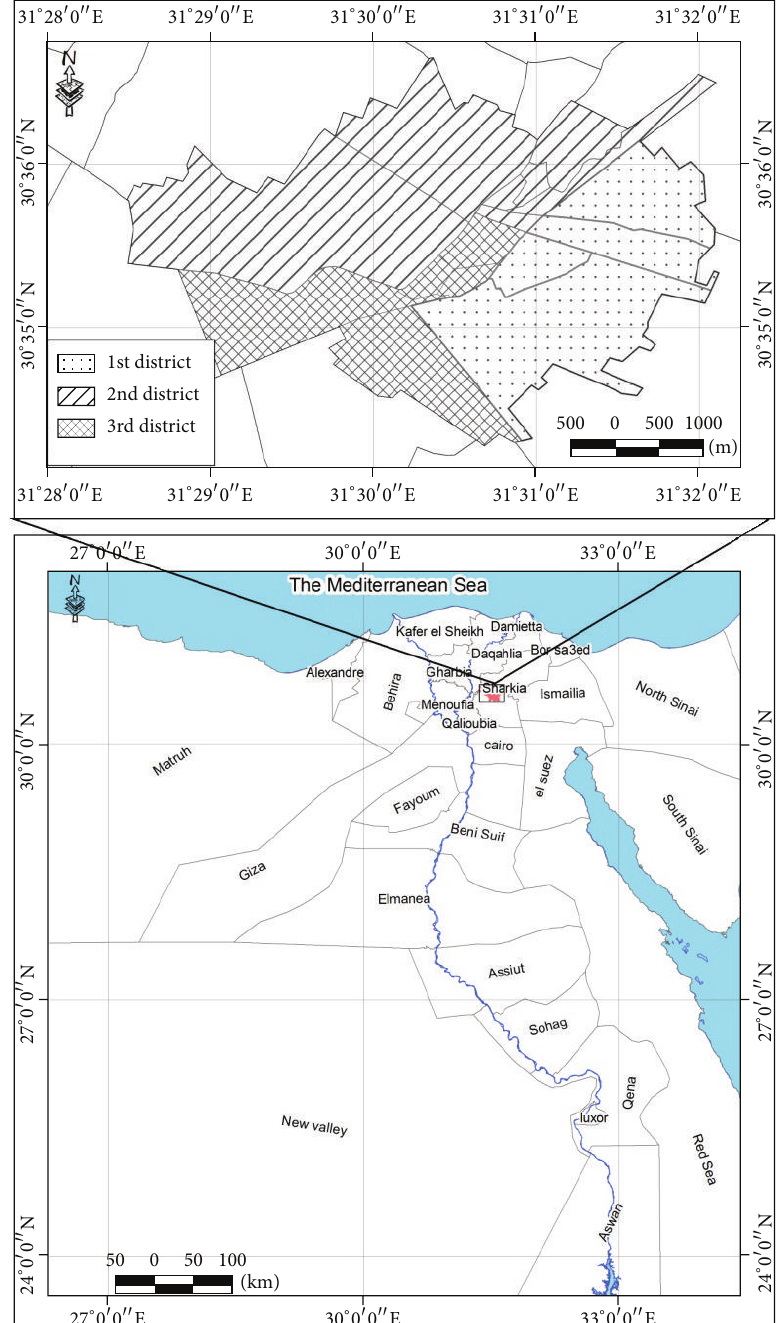
Figure 1: Location of Zagazig city in Arab Republic of Egypt (ARE) and its 3